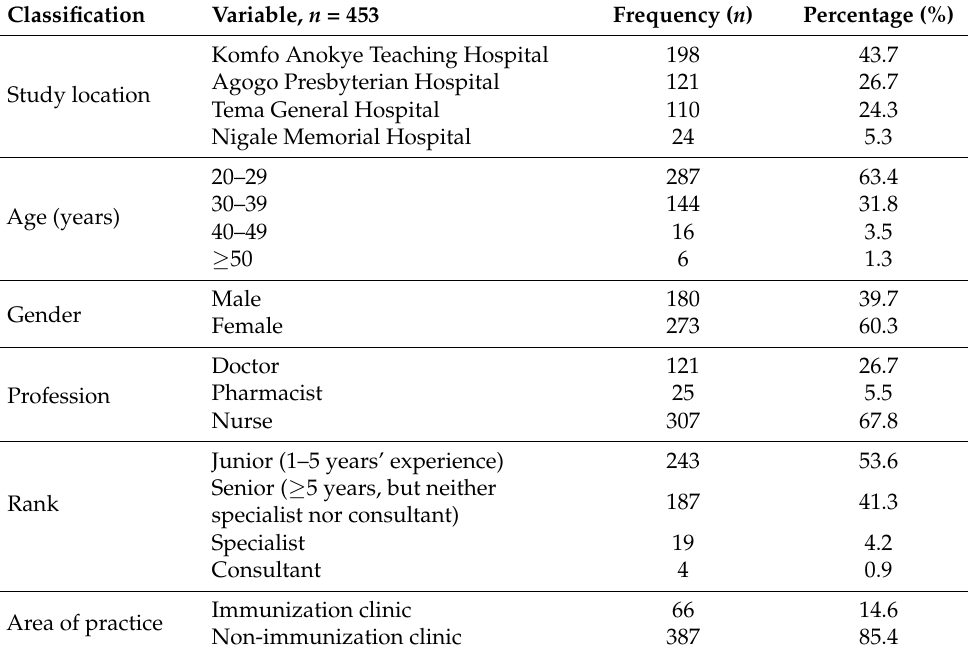
Table 2. Socio-demographic characteristics of study